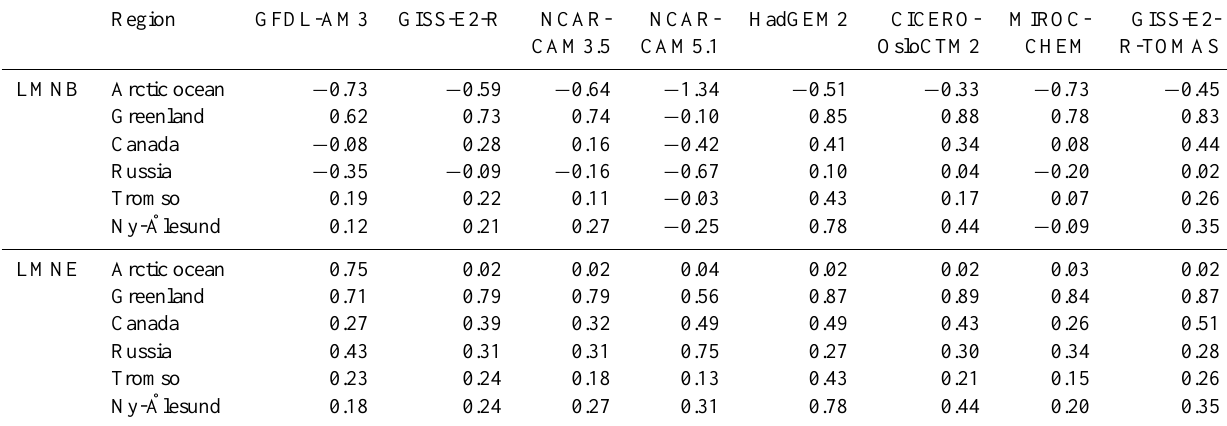
Fig. 9. Scatter plots of the observed Arctic BC snow concentrations from 1998 and 2005–2009 and the modeled BC snow concentrations that were obtained from the offline land and sea-ice models (NCAR CLM4 and CICE4, see Sect. 3 for more details). Refer to Sect. 4.3 for the data preparation. The thick and thin solid lines refer to 1 : 1 line and 2 : 1 line, respectively. The dashed line is for 10 : 1 line. Table 6. Log-mean normalized bias (LMNB) and log-mean normalized error (LMNE) of model present-day BC snow concentrations com- pared with the BC Arctic snowpack observations. Note that Canada sub-Arctic, Canadian Arctic, and Alaska N. slope regions in Fig. 9 are lumped into